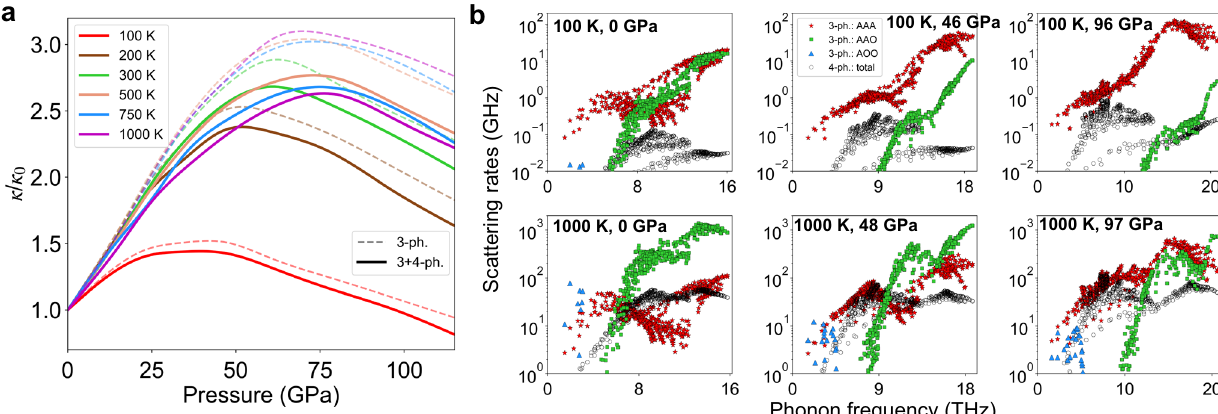
Fig. 3 Temperature dependence of the scaled thermal conductivity and phonon – phonon scattering rates of BP vs. pressure. a Pressure dependence of the κ of BP scaled by its zero pressure values, κ 0 , for different temperatures. b Process-wise three-phonon and total four-phonon scattering rates for BP at 100 K and 1000 K, and at different